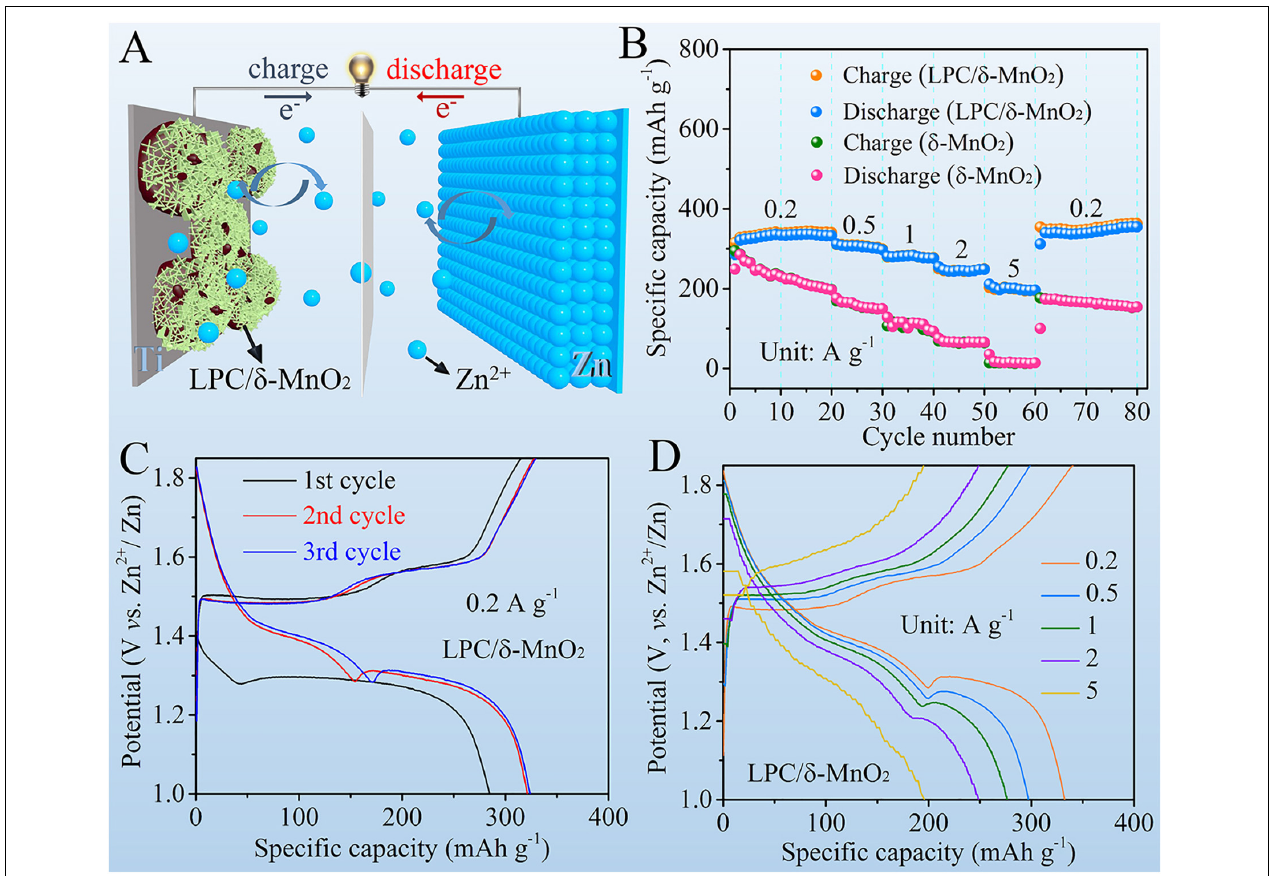
FIGURE 2 | (A) Schematic illustration of the Zn-MnO 2 battery with LPC/ δ -MnO 2 cathode material. (B) Rate performances of LPC/ δ -MnO 2 and δ -MnO 2 . (C) GCD curves of LPC/ δ -MnO 2 at the initial three cycles at 0.2 A g - 1 . (D) GCD curves of LPC/ δ -MnO 2 at different current densities.